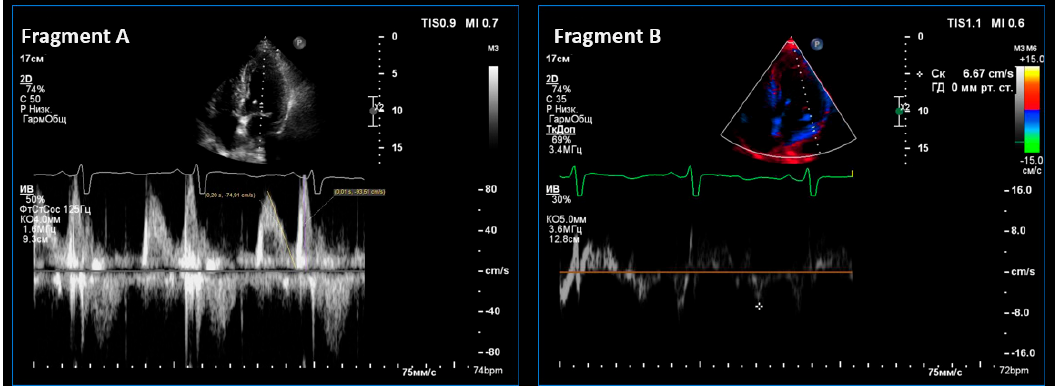
Figure 2. An episode of echocardiography in Participant A. (male, 55 years old). In the Doppler mode (Fragment A), transmitral blood flow is shown with an assessment of Peaks E and A. In the tissue, the Doppler mode and the fibrous ring of the mitral valve movement are shown in the left ventricle early-filling phase.